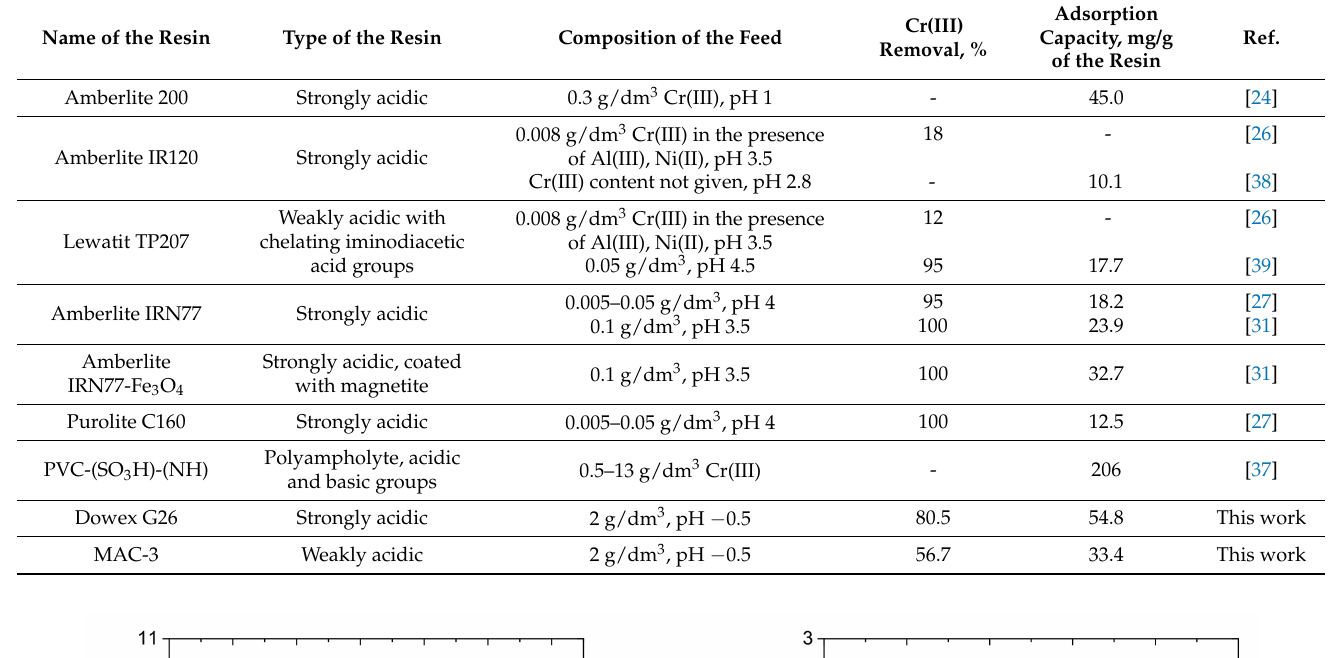
Table 6. Comparison of the performance of some cation exchange resins in Cr(III) adsorption.